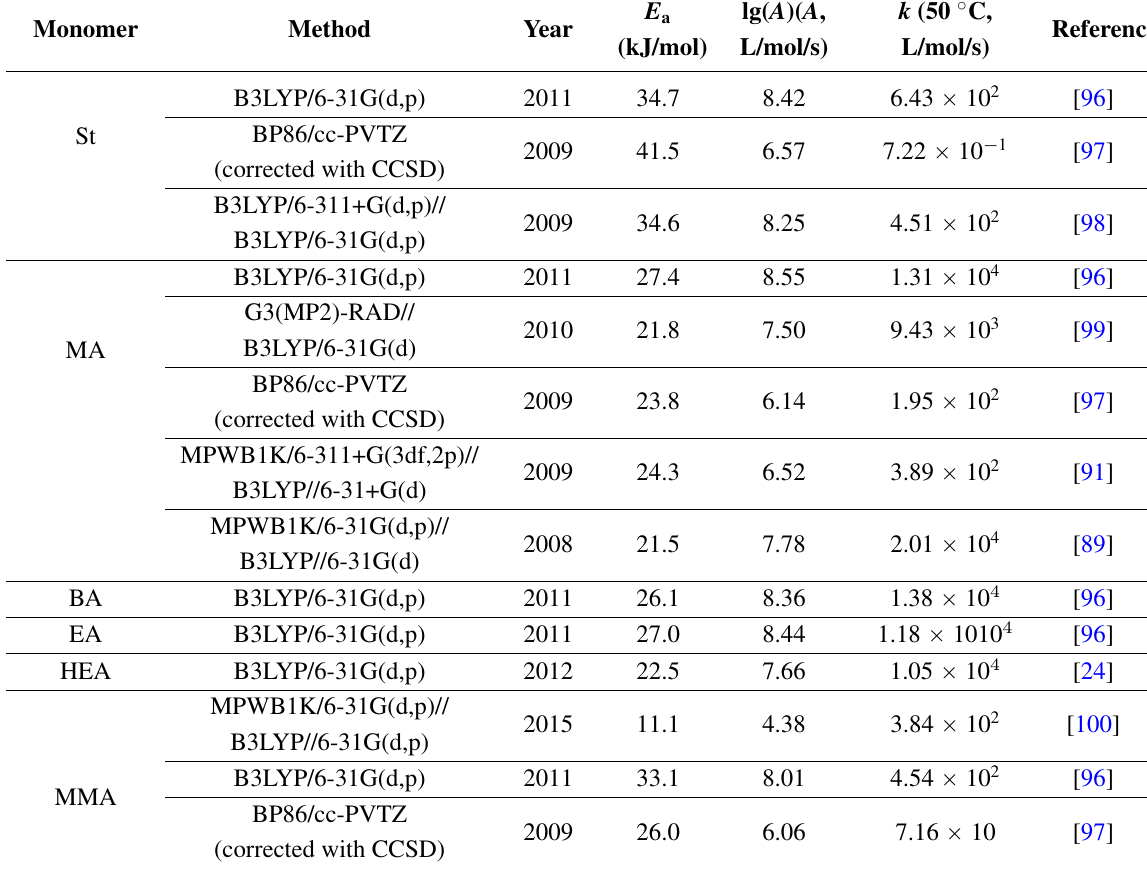
Table 2. Propagation rate coefficients, k , and Arrhenius parameters (activation energy, E , and pre-exponential factor, A ) of the free radical polymerization of various monomers a estimated through quantum chemistry (QC)